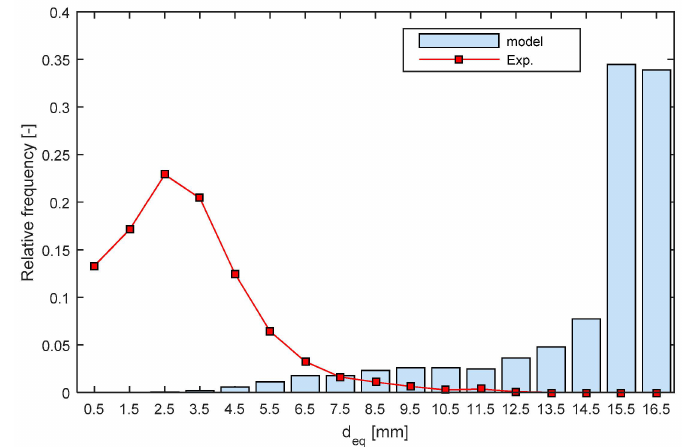
Figure 11. Comparison between PBM and experimental data: uniform BSD at the inlet: U G = 0.0188 m/s.